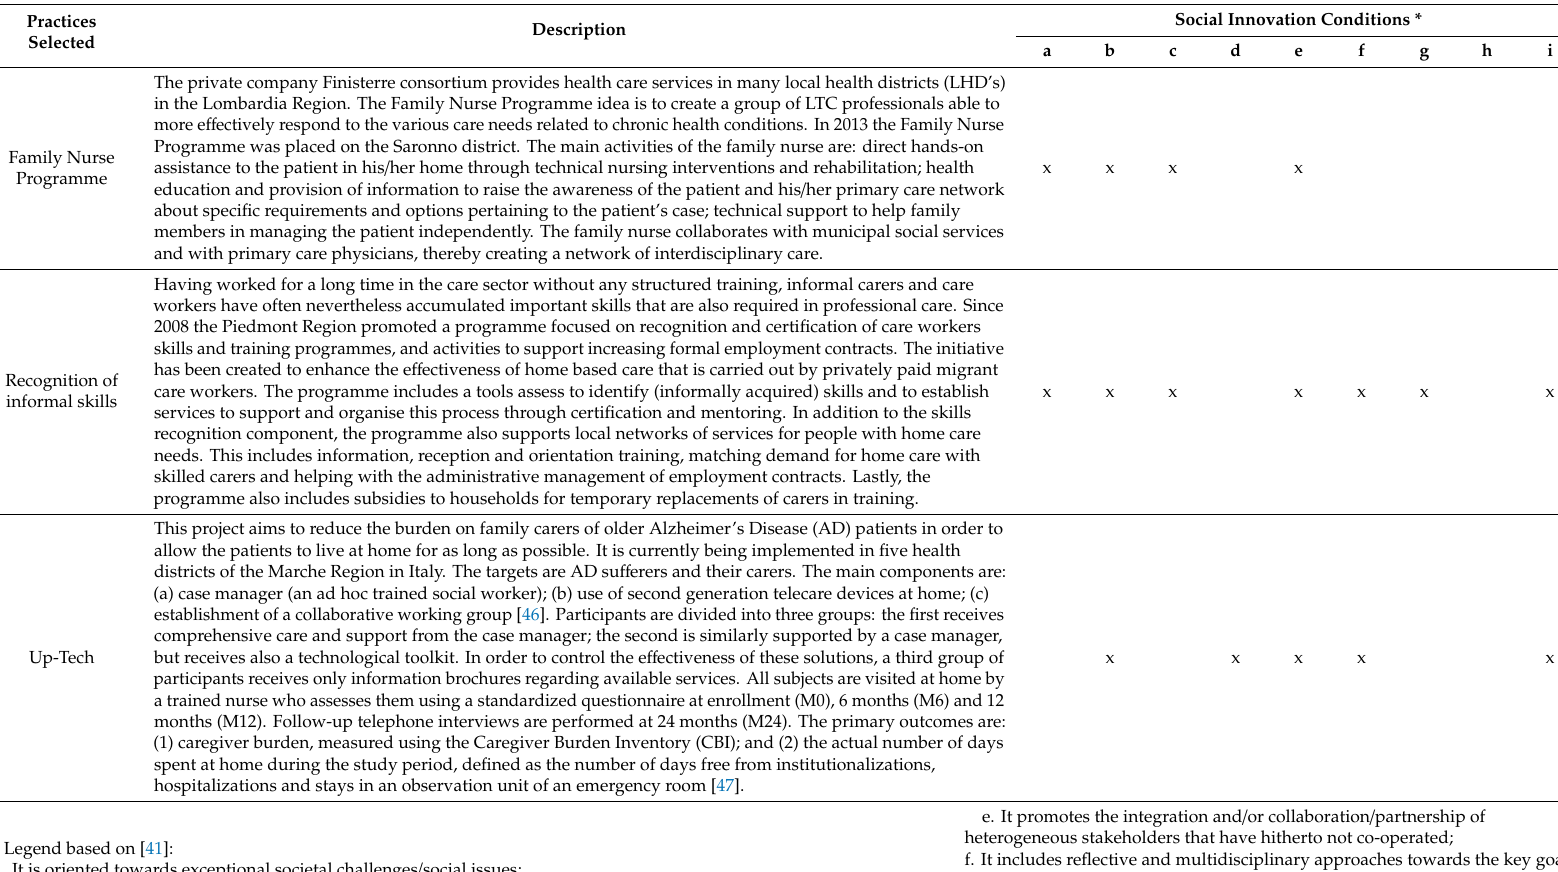
Table 2. Italian good practices and conditions of social